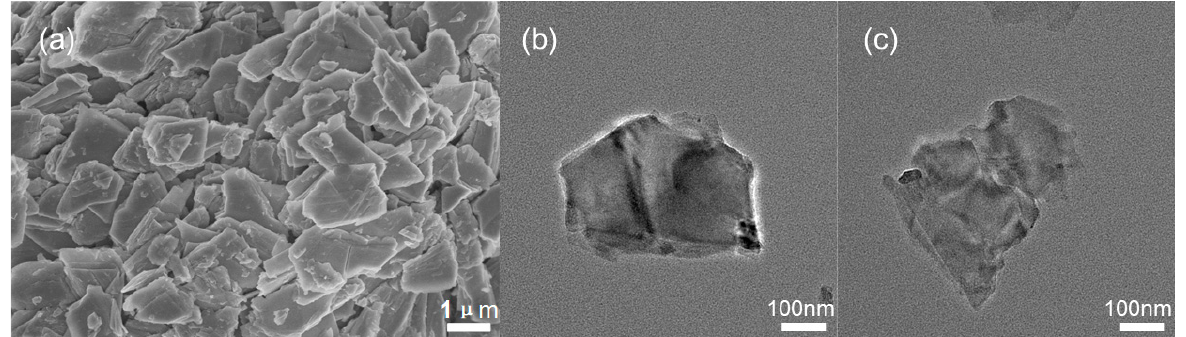
Figure 2. The characterizations of nanometer SnS 2 ( a ) FESEM ( b , c ) TEM. The XPS characterization results of SnS 2 nanomaterials are shown in Figure 3. As shown in Figure 3a, Sn 3d and S 2p are located in the range of 480~500 eV and 160~170 eV, respectively. The scan patterns of Sn 3d and S 2p are shown in Figure 3b,c. Sn 3d in Figure 3b shows two distinct peaks at 487 eV and 495 eV, corresponding to Sn 3d 5/2 and Sn 3d 3/2 in the +4 valence state, respectively. S 2p is shown in Figure 3c with two peaks at 162 eV and 163 eV corresponding to S 2p 3/2 and S 2P 1/2 , respectively. The XPS characterization results prove that the SnS 2 samples prepared above were of good purity and basically free of other impurity elements.